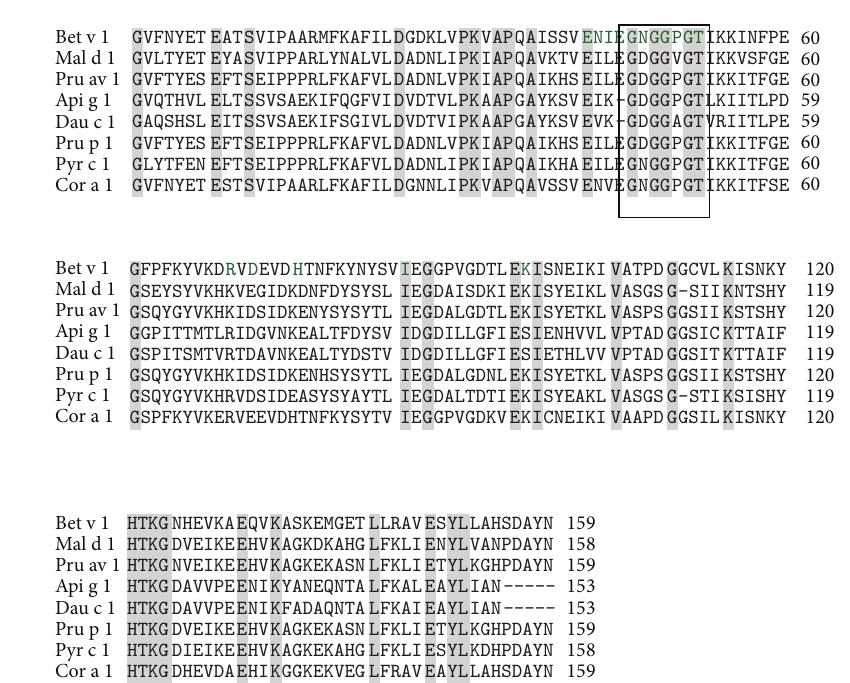
Figure 11: Multiple sequence alignment of birch pollen allergen Bet v 1 with food allergens: Mal d 1, Pru av 1, Api g 1, Dau c 1, Pru p 1, Pyr c 1, and Cor a 1. The identical sequences are highlighted in grey. The residues of Bet v 1 responsible for IgE binding are marked in green. The nearly conserved glycine rich loop is highlighted in box.